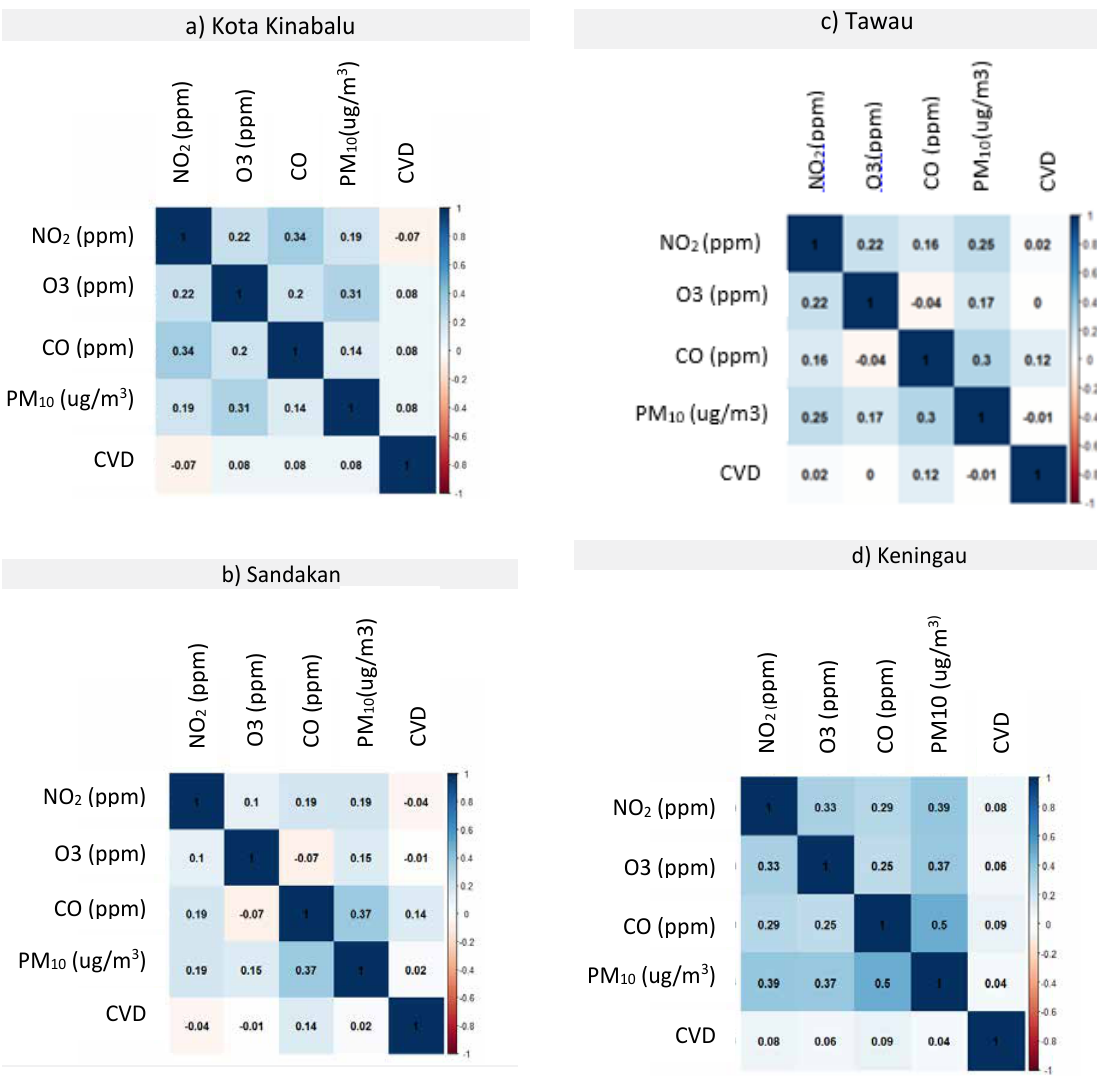
Fig. 3: Correlation coefficient between the air pollutants and cardiovascular hospital admission in Sabah 2010–2019 (a)Kota Kinabalu (b)Sandakan (c)Tawau (d)Keningau